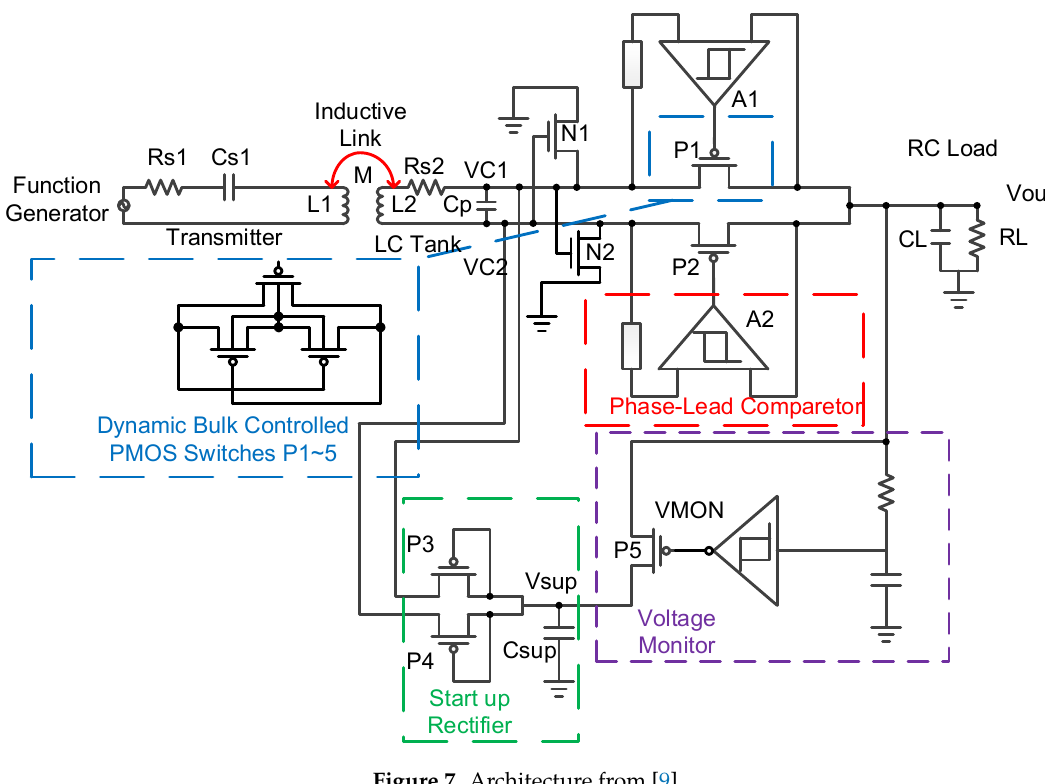
Figure 7. Architecture from [9].